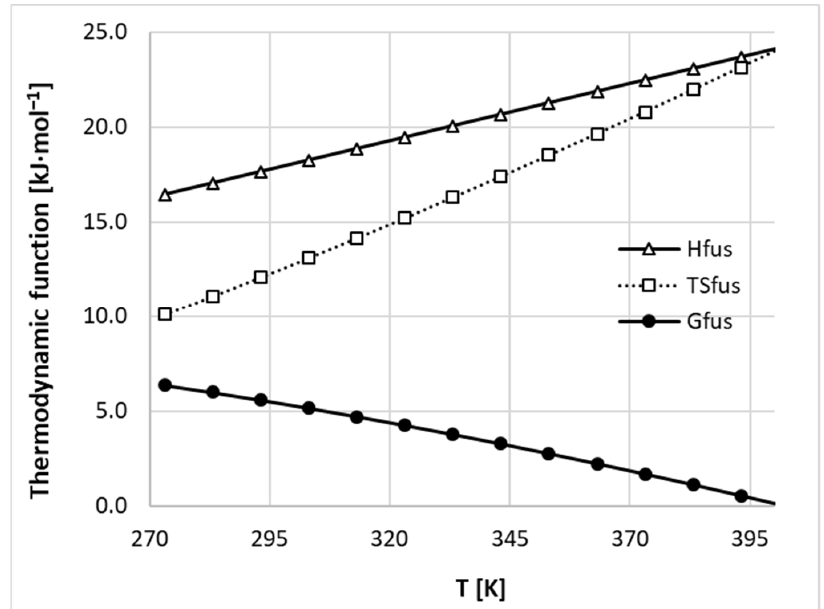
Figure 2. Temperature related changes of thermodynamic functions of nicotinamide fusion.